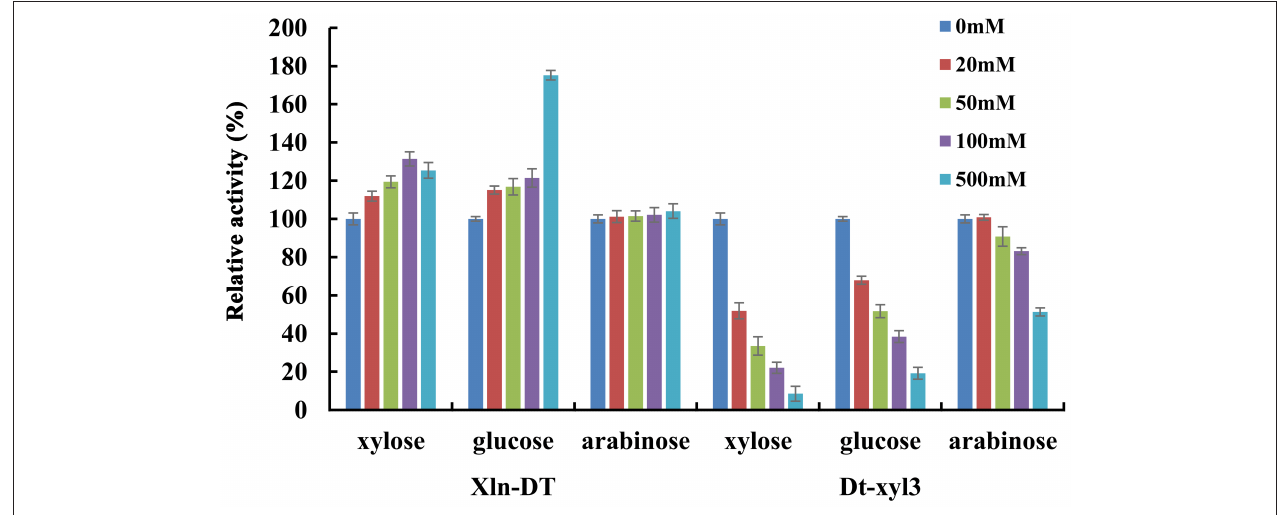
FIGURE 4 | The effects of xylose/glucose/arabinose on the activities of recombinant β -xylosidase Xln-DT and Dt-xyl3 (column: 0, 20, 50, 100, or 500mM concentration of sugar). The activity of β -xylosidase enzyme without xylose/glucose/arabinose was defined as relative 100%. Influence of xylose/glucose/arabinose on enzyme activity with p- nitrophenyl- β - D -xylopyranoside.